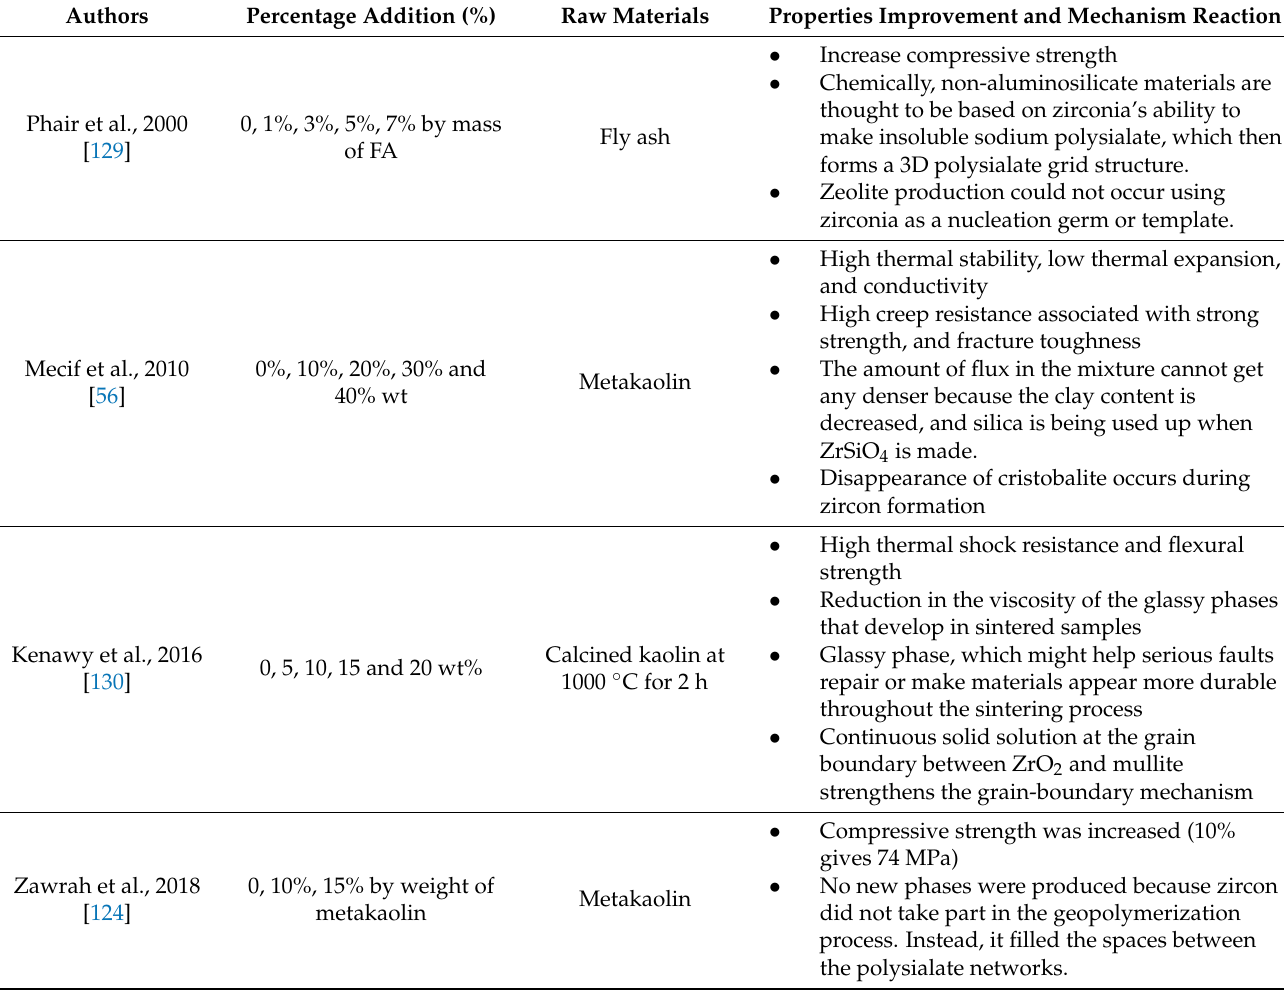
Table 10. Impact of the addition of zirconia in past